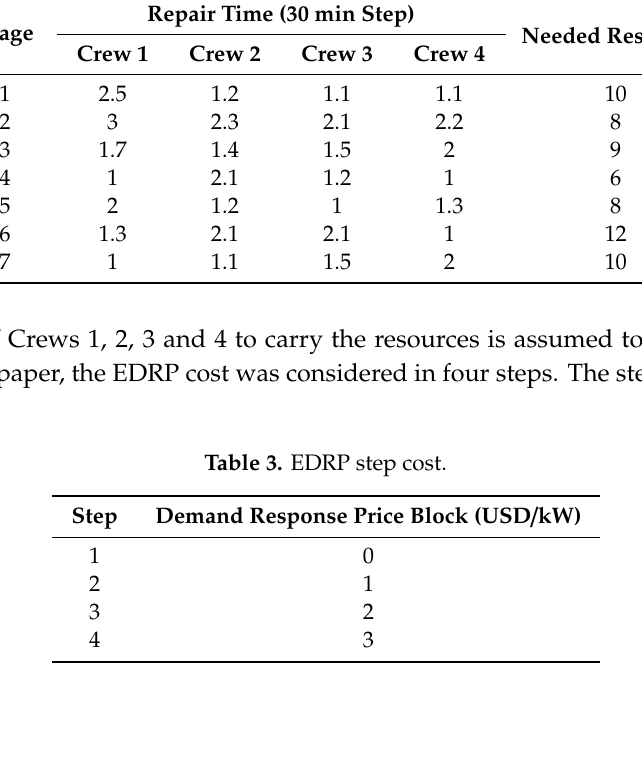
Table 1. Parameters of DG.